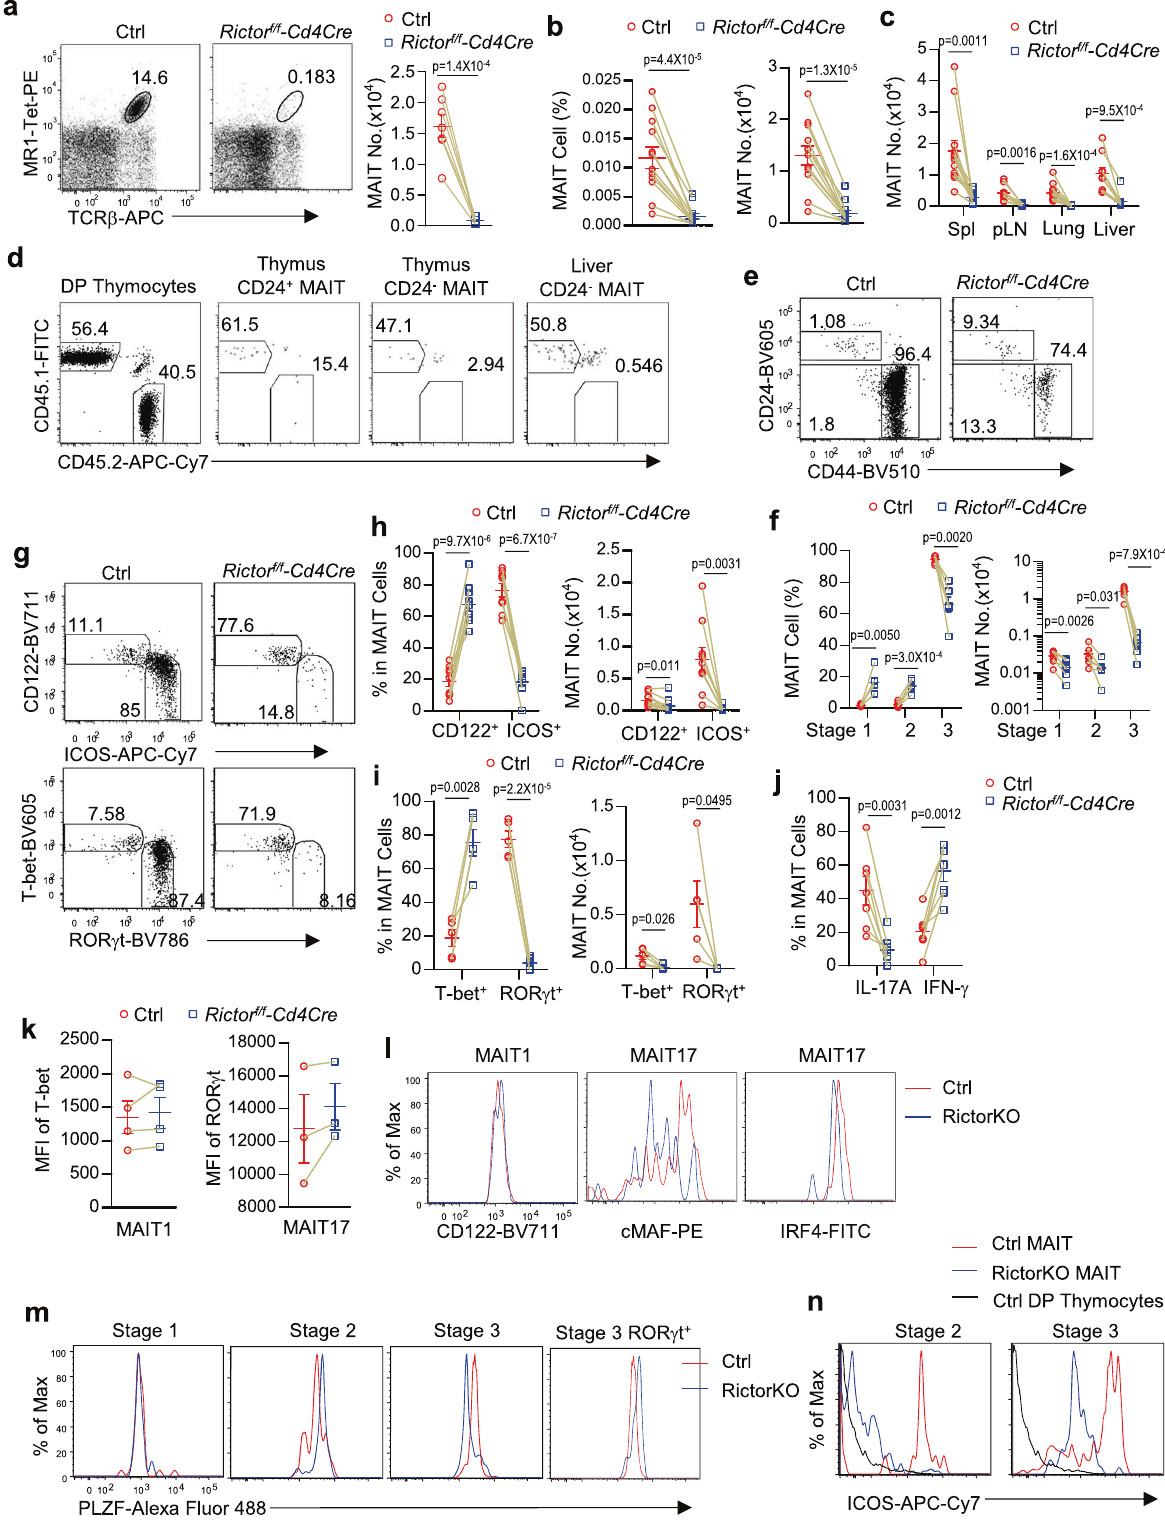
MAIT1 cells. Regardless of these differences, these two cytokines synergistically promote MAIT cell expansion in vitro and, par- ticularly, in vivo. Because these cytokines are induced during infection and in fl ammatory conditions, signals from their receptors may play important roles in MAIT cell differentiation into different effector lineages and homeostasis of these cells.